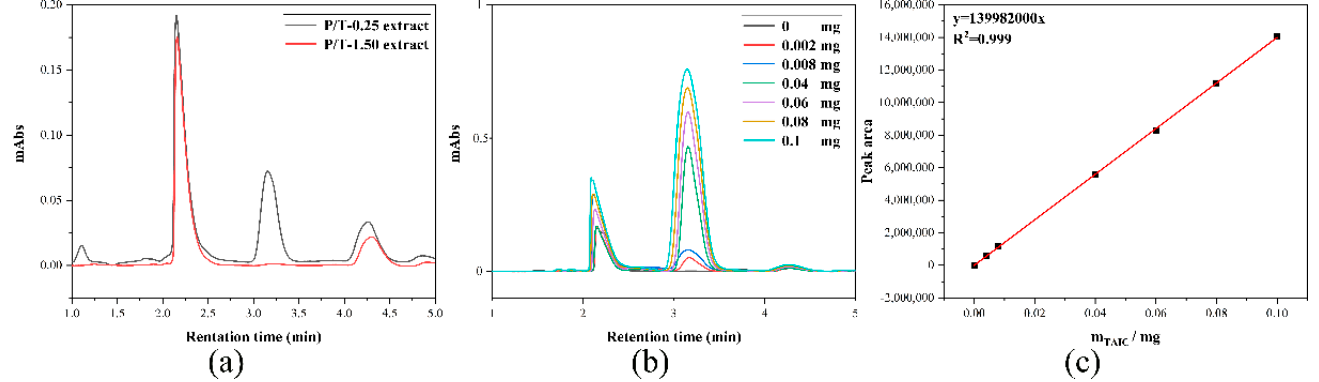
Figure 6. ( a ) Chromatograms of extracts from P/T-0.25 and P/T-1.50; ( b ) HPLC chromatograms of TAIC/MEK solution with different TAIC mass fractions; ( c ) TAIC calibration curve. The abscissa was the detected TAIC quality, and the ordinate was the area of TAIC peak.